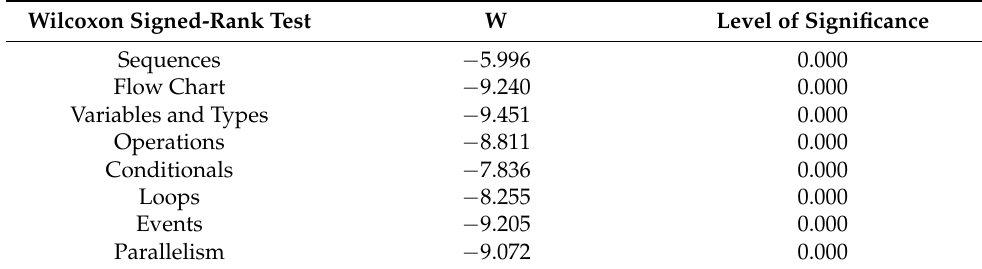
Table 8. Signed-rank test for the complete population and grouped by programming